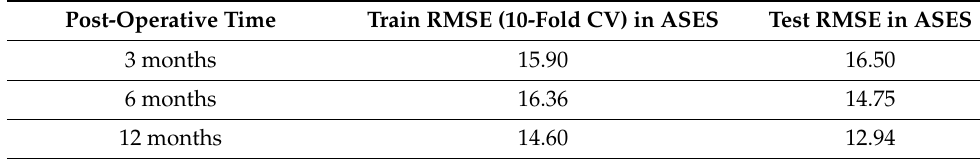
Table 2. Root-mean-square error (RMSE) calculated using 10-fold cross-validation for train and test datasets at different post-operative